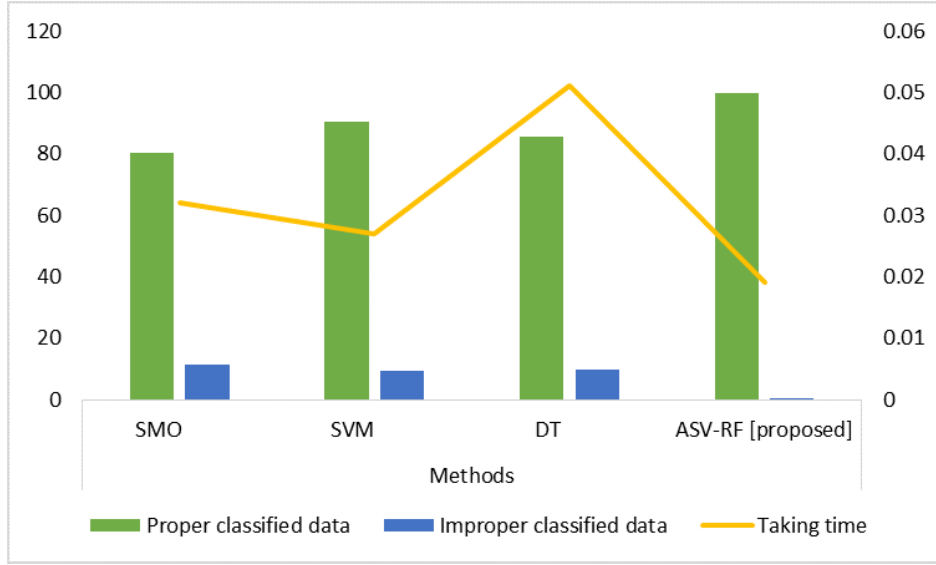
Figure 3. Proper and improper classifications’ results.